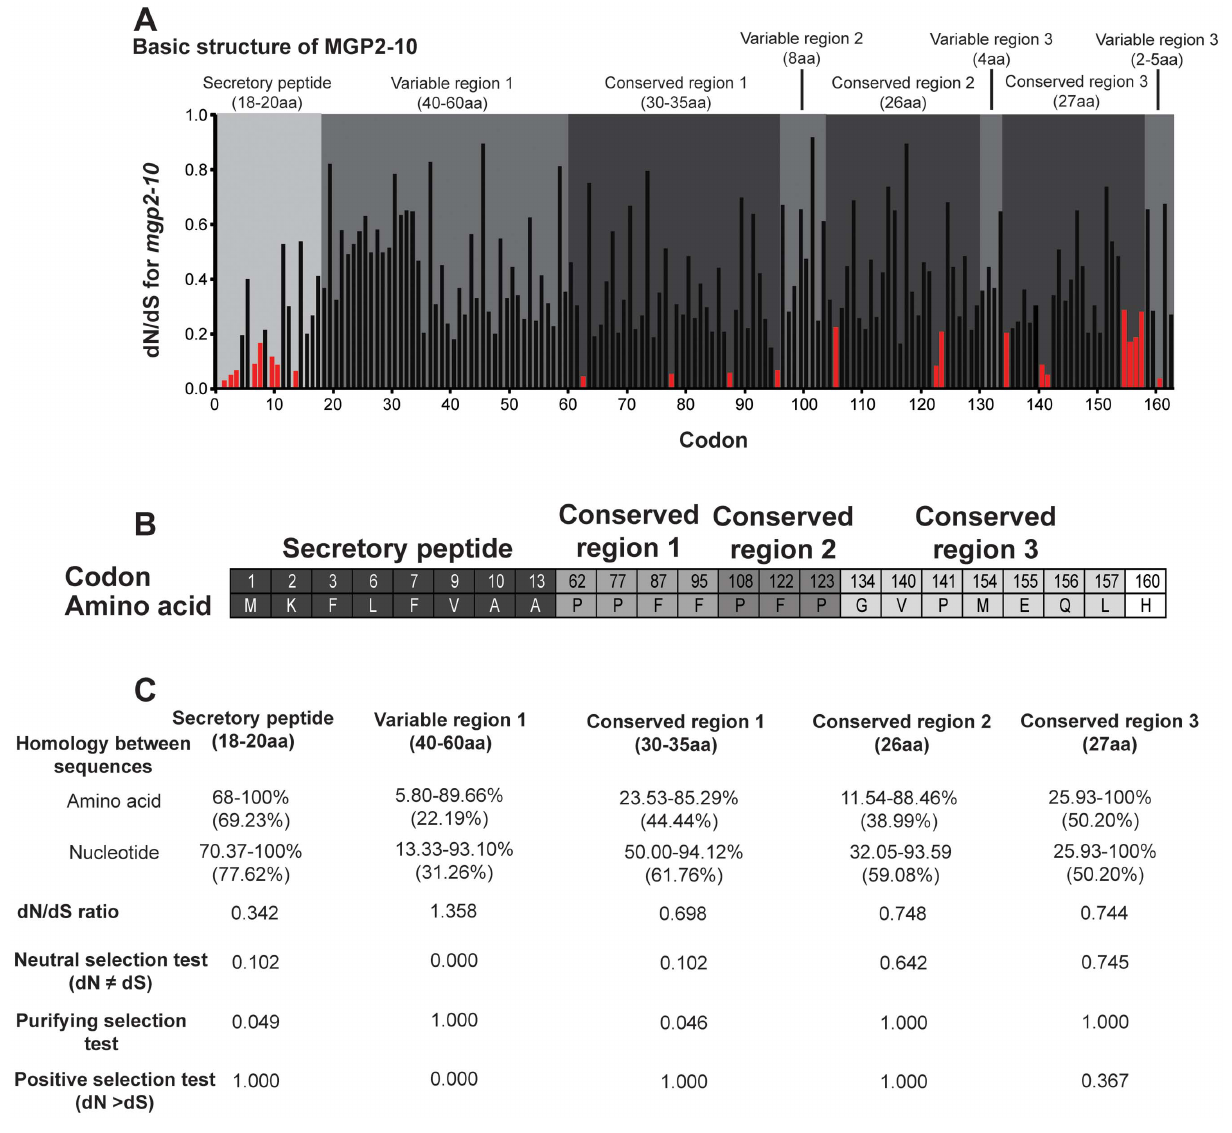
Figure 7. Selective pressure acting upon mgp gene family. (A) Site-specific dN/dS analysis along a multiple alignment of MGP coding sequences. Residues identified as subject to negative selection under FEL analysis (posterior probability cutoff=95) are indicated in red. Regions are described as conserved or variable according to visual examination of the multiple alignment and corroborated by dN/dS anslysis. (B) Specific codons and their corresponding amino acid sequence under negative selection. (C) Percent amino acid and nucleotide homology, average dN/dS ratio and selection tests for specific regions of MGP2–10. Positive, neutral and purifying test were conducted with codon-based Z-test in MEGA5 [25].